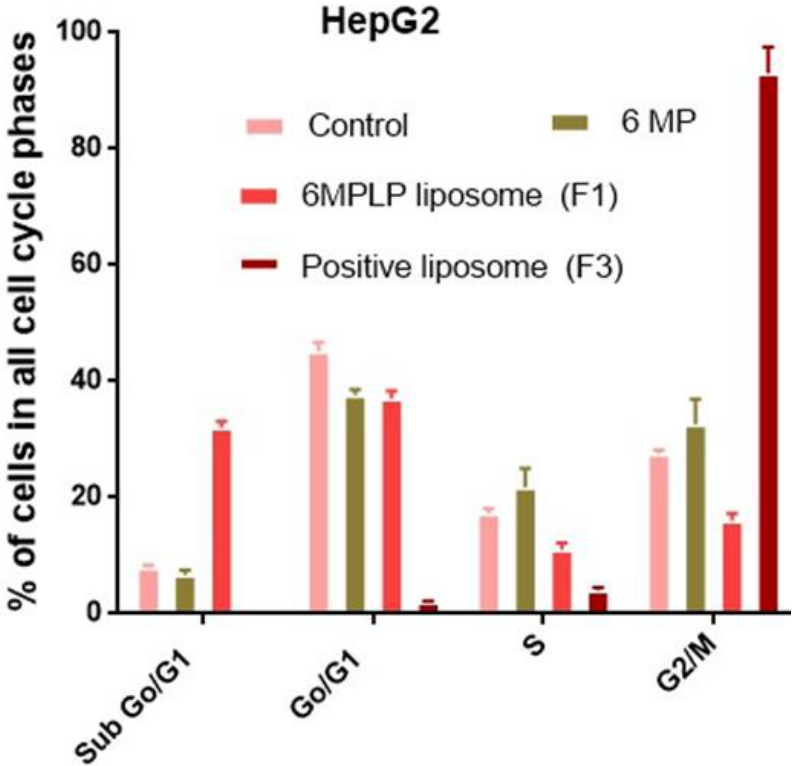
Figure 4. Percentage of cells in all cell cycle phases in HepG2 treated with free 6-MP and loaded with positive charged liposome.